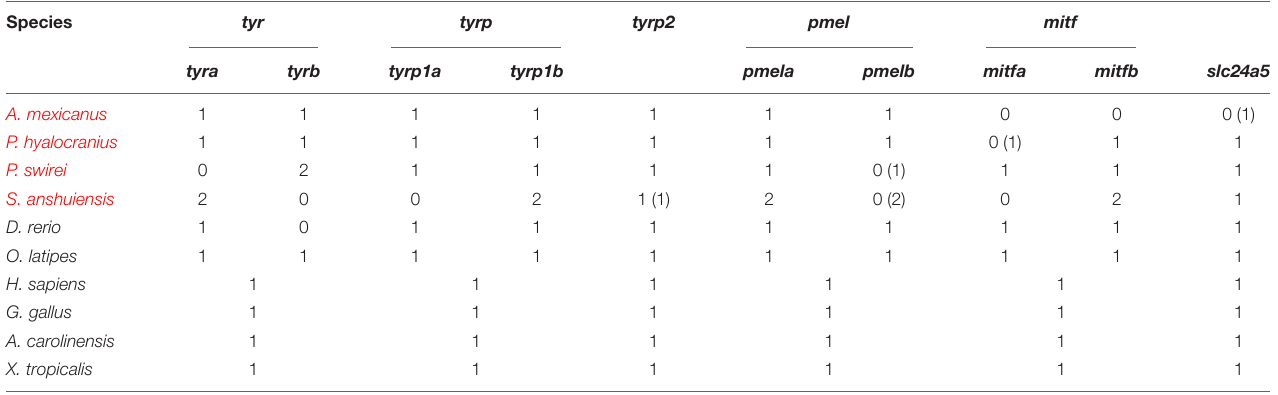
TABLE 2 | Copy numbers of representative genes for melanin synthesis in 9 representative vertebrate species. Species tyr tyrp tyrp2